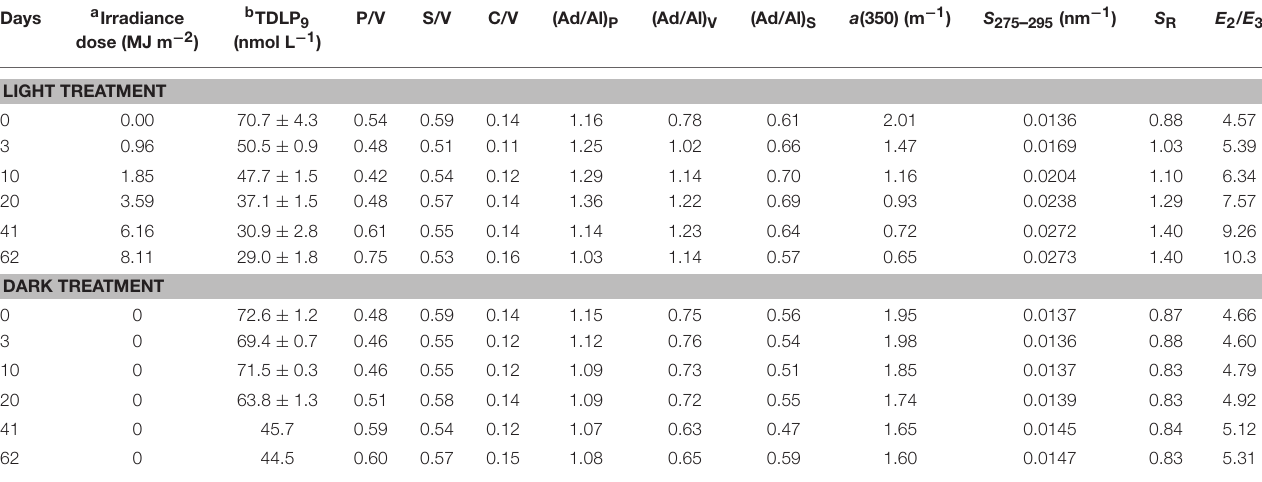
TABLE 3 | Decomposition experiments of DOM in Unosumai River water under natural sunlight and dark treatments. Days a Irradiance